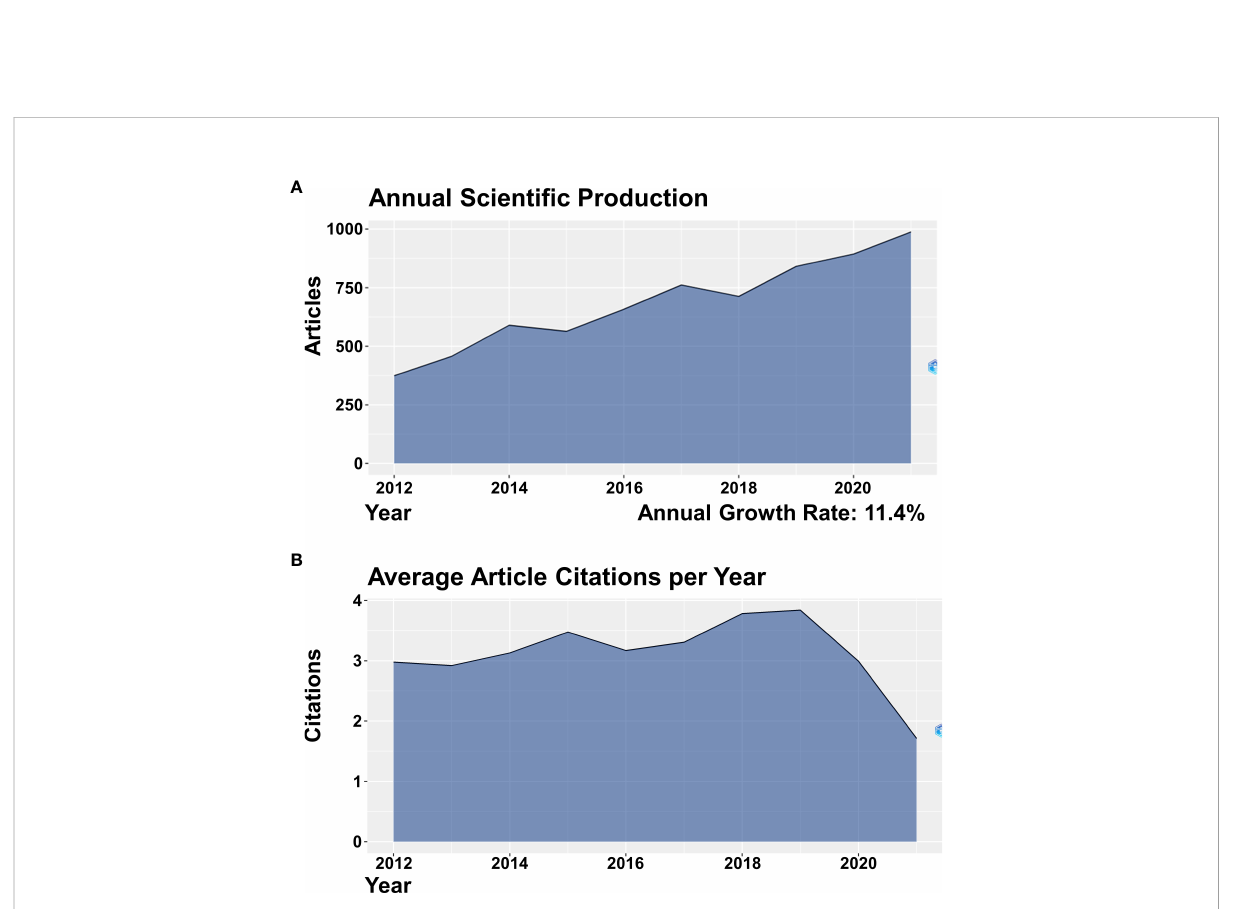
FIGURE 2 (A) Annual scienti fi c production in ESCC research from 2012 to 2021. (B) Average article citations per year in ESCC research from 2012 to 2021.